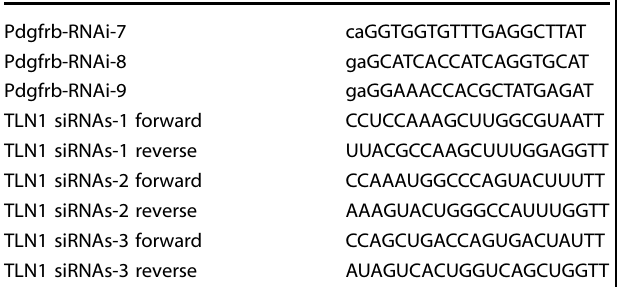
Table 2. The target sequences used for PDGFR- β knockdown lentivirus or